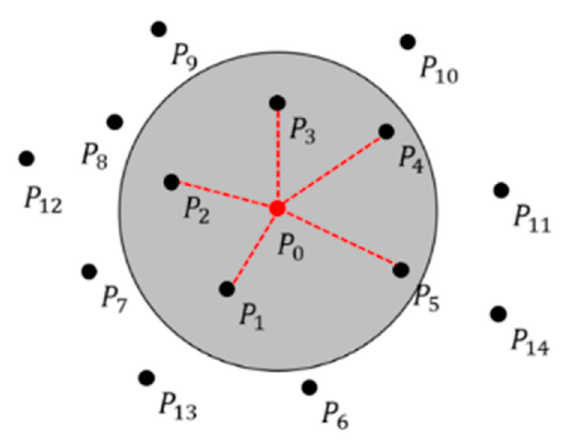
Figure 9. FPFH calculation schematic diagram.